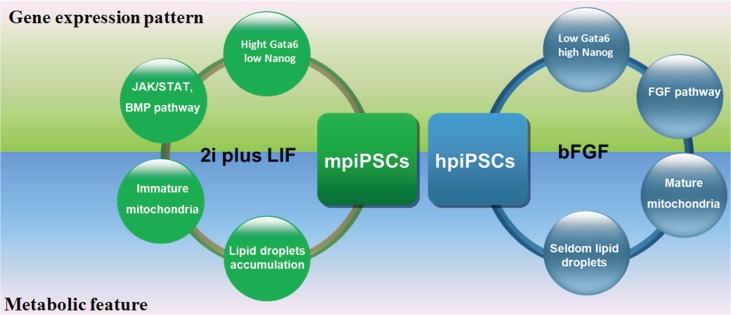
A model showed the difference between two types of piPSCs.The two types of piPSCs derived from mESC medium (2i plus LIF) and hESC medium (containing bFGF) showed the different characteristics in gene expression pattern and metabolic feature.